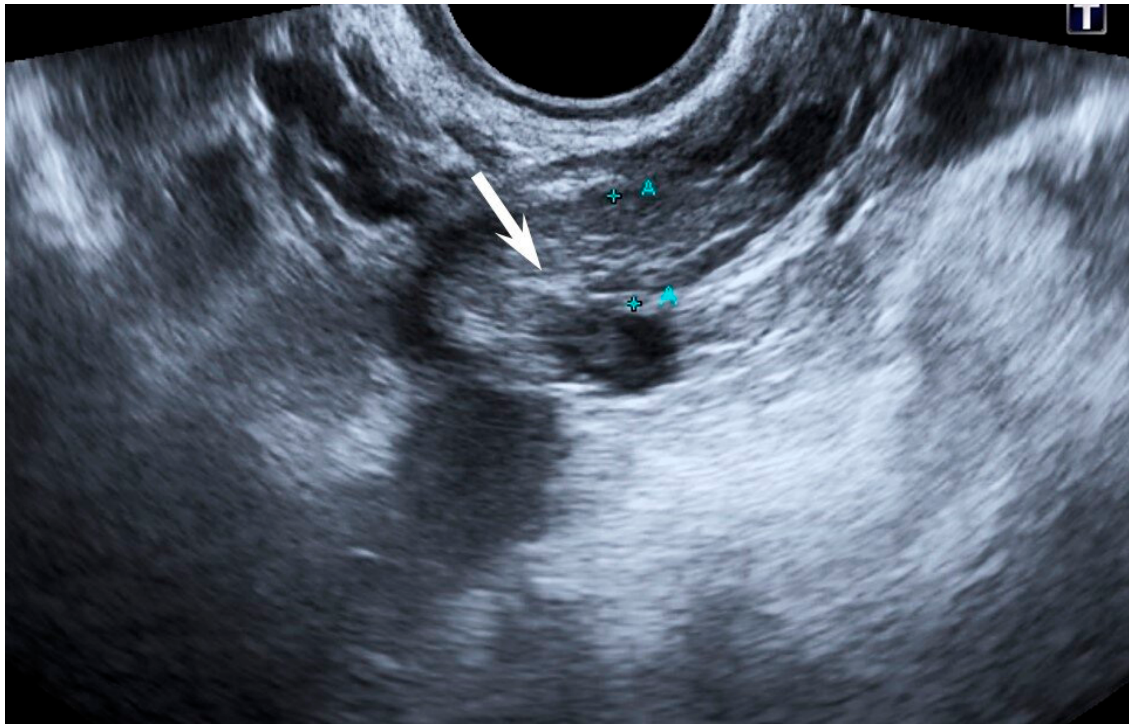
Figure 3. Duplex ultrasound scanning. Blood clot in the lumen of a parametrial vein (arrow).